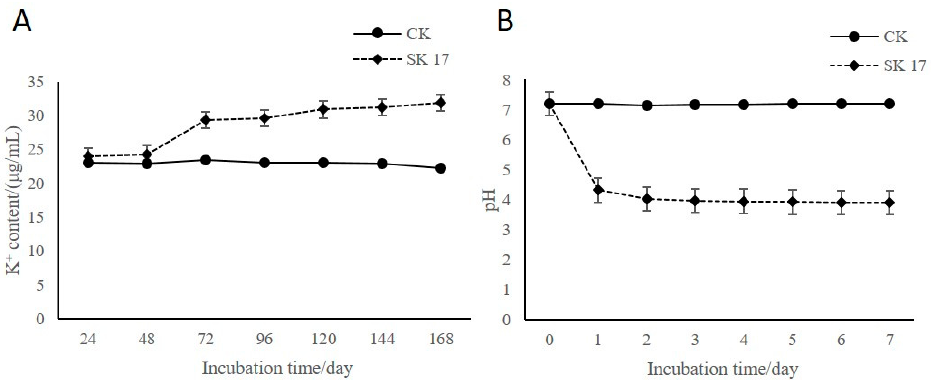
Figure 1. Solubilization of potassium feldspar by Bacillus aryabhattai SK1-7. CK: added with LB medium and water. SK1-7: inoculated with strain B. aryabhatta. ( A ) Changes in the potassium ion concentration in the potassium-solubilizing fermentation medium after 7 days of cultivation. ( B ) Changes in the pH of the potassium-decomposing fermentation medium after 7 days of cultivation. The error bars indicate standard